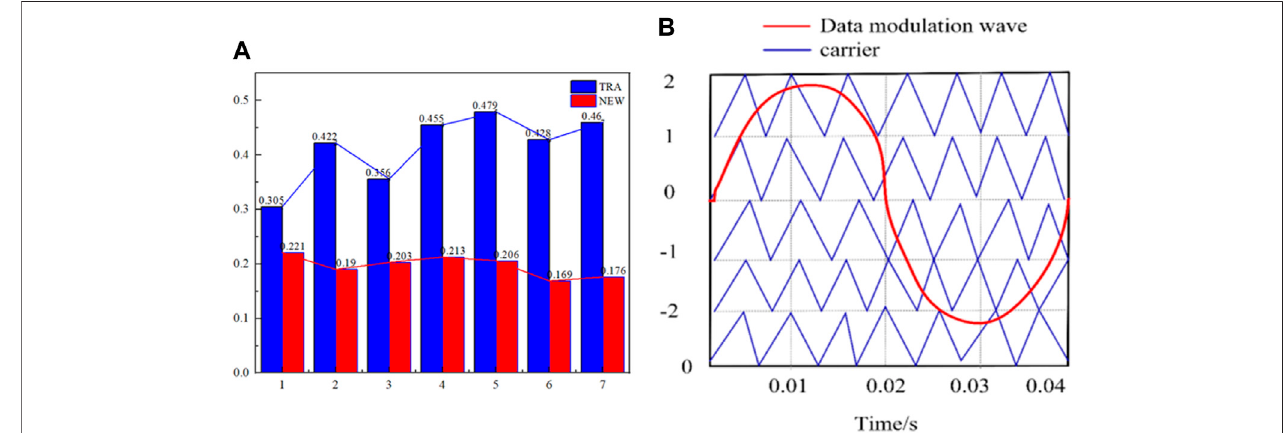
FIGURE 1 | Five level data modulation